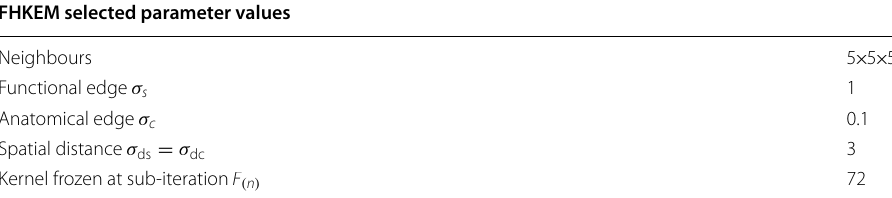
Table 1 FHKEM selected parameter values FHKEM selected parameter